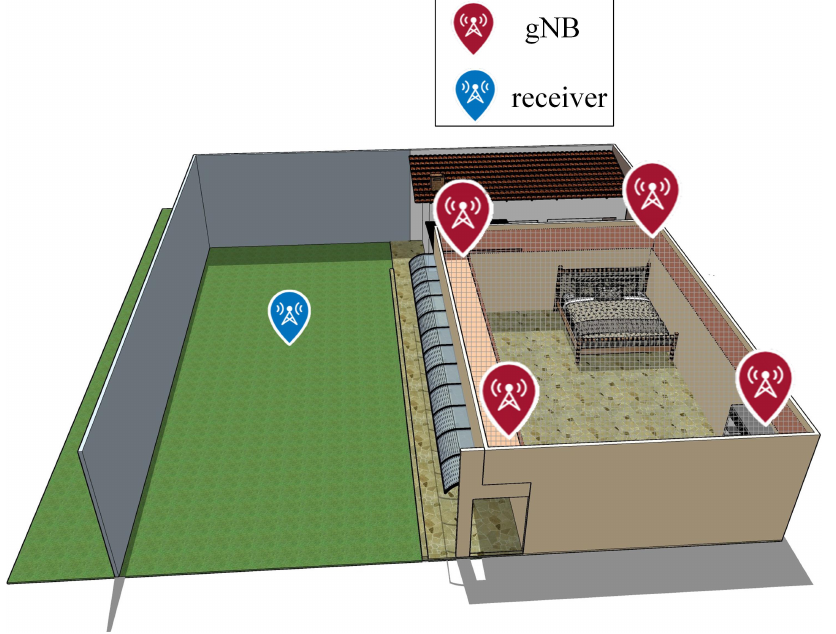
Figure 15. Three-dimensional (3D) schematic diagram of villa scene.